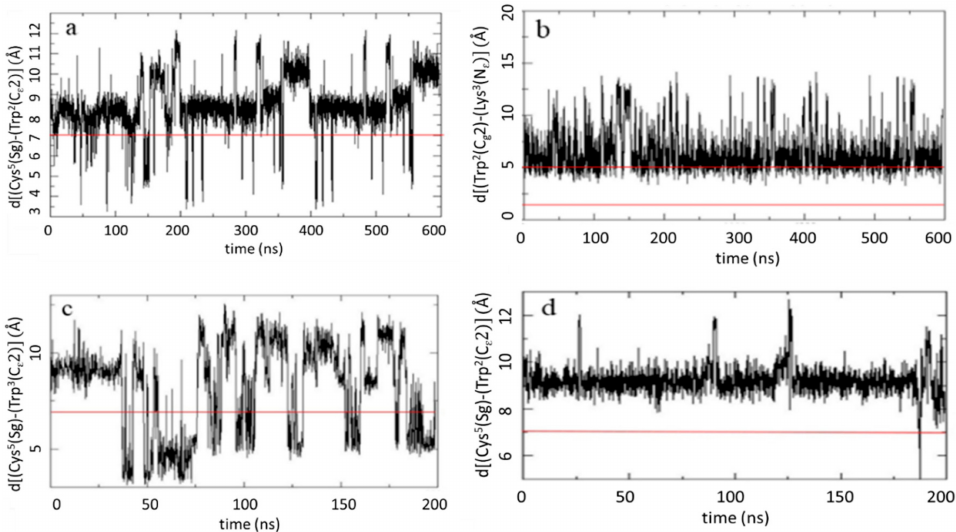
Figure 4. Key interatomic distances (in Å) relevant for photolytic processes. The required criteria are represented by red lines. Distance between the disulfide bridge and the Trp ring d[Cys 5 (S γ )-Trp 2–3 (C ε 2)] along three concatenated ( a : Ac-c(CWKAC)-NH 2 ) and 200 ns long ( c : Ac-c(CAWAC)-NH 2 , d : Ac-c(CWAGC)-NH 2 ) MD-trajectories. Distance between Trp ring and Lys side chain d[Trp 2 (C ε 2)-K 3 (N ε )] along three concatenated MD-trajectories ( b : Ac-c(CWKAC)-NH 2